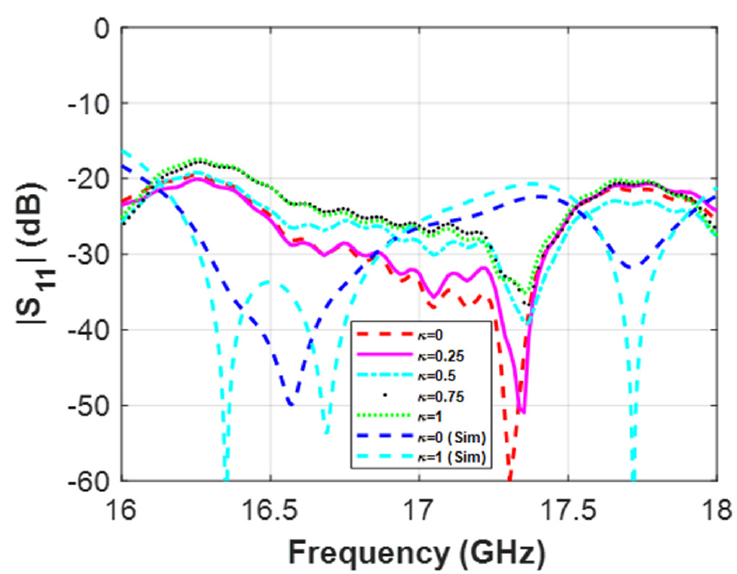
Figure 8. Measured and simulated (Sim) magnitude of the reflection coefficient at the input of one of the WRPS (the phase-shifter marked as I in Figure 6) for different values of TS (tuning screw) penetration.